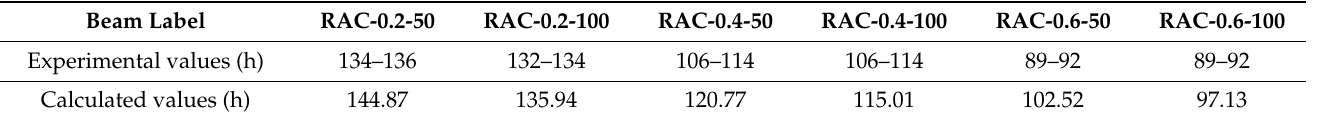
Table 1. Comparison of calculated values and experimental values of CLC time of CCS under